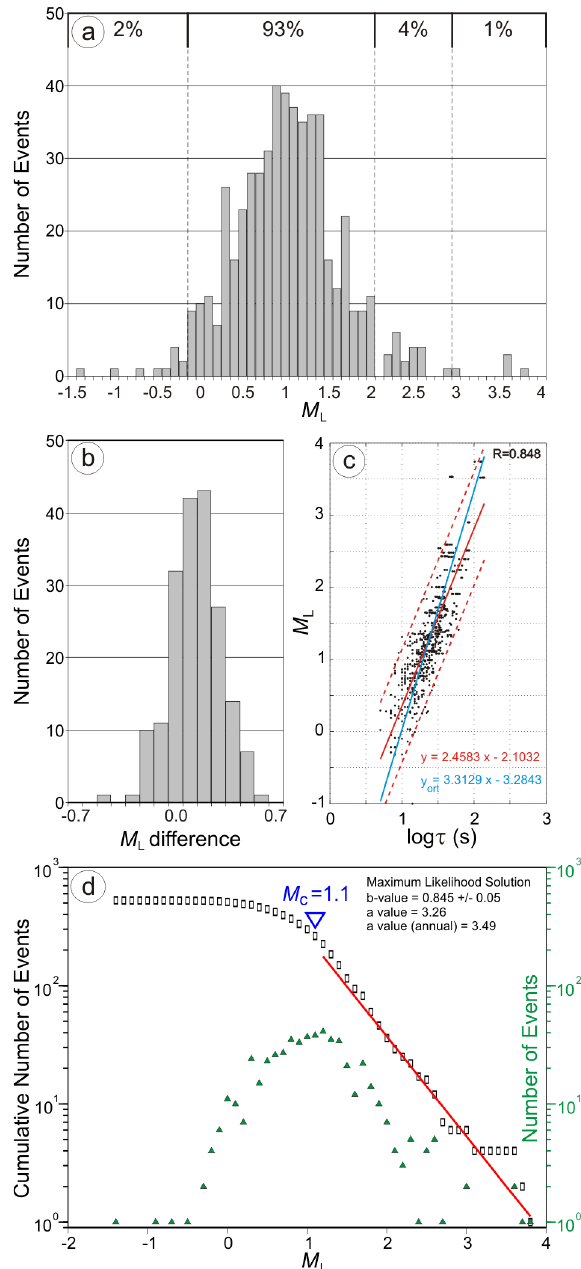
Fig. 10. (a) Histogram of M L estimates of earthquakes localized in this study. At the top of the histogram, the percentages of the events within the corresponding range of magnitude are reported. (b) Histogram of the residuals between local magnitude estimated in this study and that reported on ISIDE database for coincident events. (c) Calibration of M D magnitude through linear regression of M L against event duration ( τ) . In red and blue, the ordinary least- squares and orthogonal regressions, respectively. Dashed lines rep- resent the standard deviation of ordinary least-squares regression. (d) Gutenberg–Richter slope evaluated with 527 events for which M L has been estimated. In blue, the magnitude of completeness M c